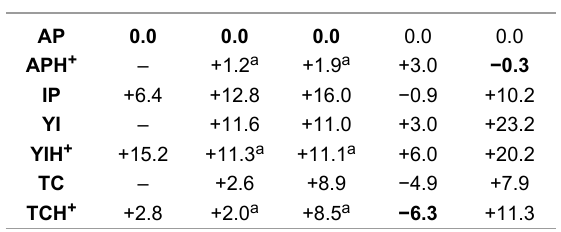
numbers of atoms and so the energies would not be directly comparable. Table 1: Calculated relative energies (kcal/mol) of the various ThDP states. The most stable state for each model is indicated in bold face.